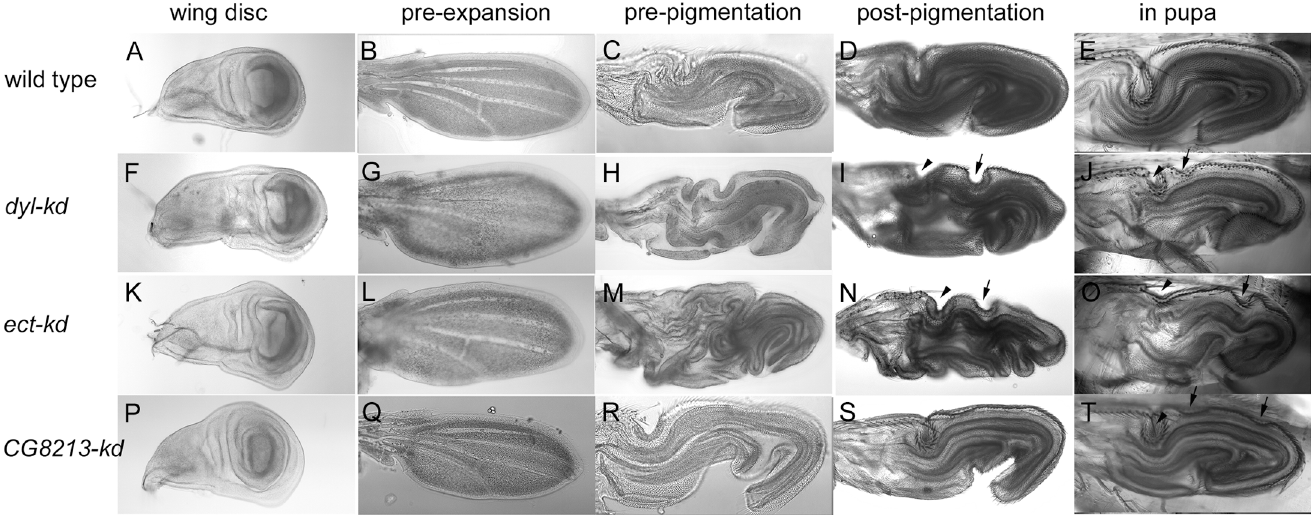
Fig 1. Changes in pupal wing morphology over time in wild type and mutants. Shown are wing discs and pupal wings from wild type (Ore-R (A-E), dyl -kd (F-J), ect -kd (K-O) and CG8213 -kd (P-T) animals. The wing discs were dissected from wandering third instar larvae and during this period the disc prepares for evagination. This leads to some discs being a bit more 3 dimensional (this can be seen in panel F). The folding pattern seen in post- flattening/expansion wild type pupal wing discs is highly reproducible. The mutants are more variable from animal to animal. This was particularly true for ect , where males showed a stronger phenotype than females. The final column shows pigmented pupal wings imaged through the pupal case and establishes that the differences between wild type and mutants are not due to dissection. The arrowheads point to shallower than normal proximal anterior folds and the arrows to ectopic folds seen in mutants. Note that during the process of dissection there is often some relaxation in the folding pattern of younger (pre-pigmentation) pupal wings.